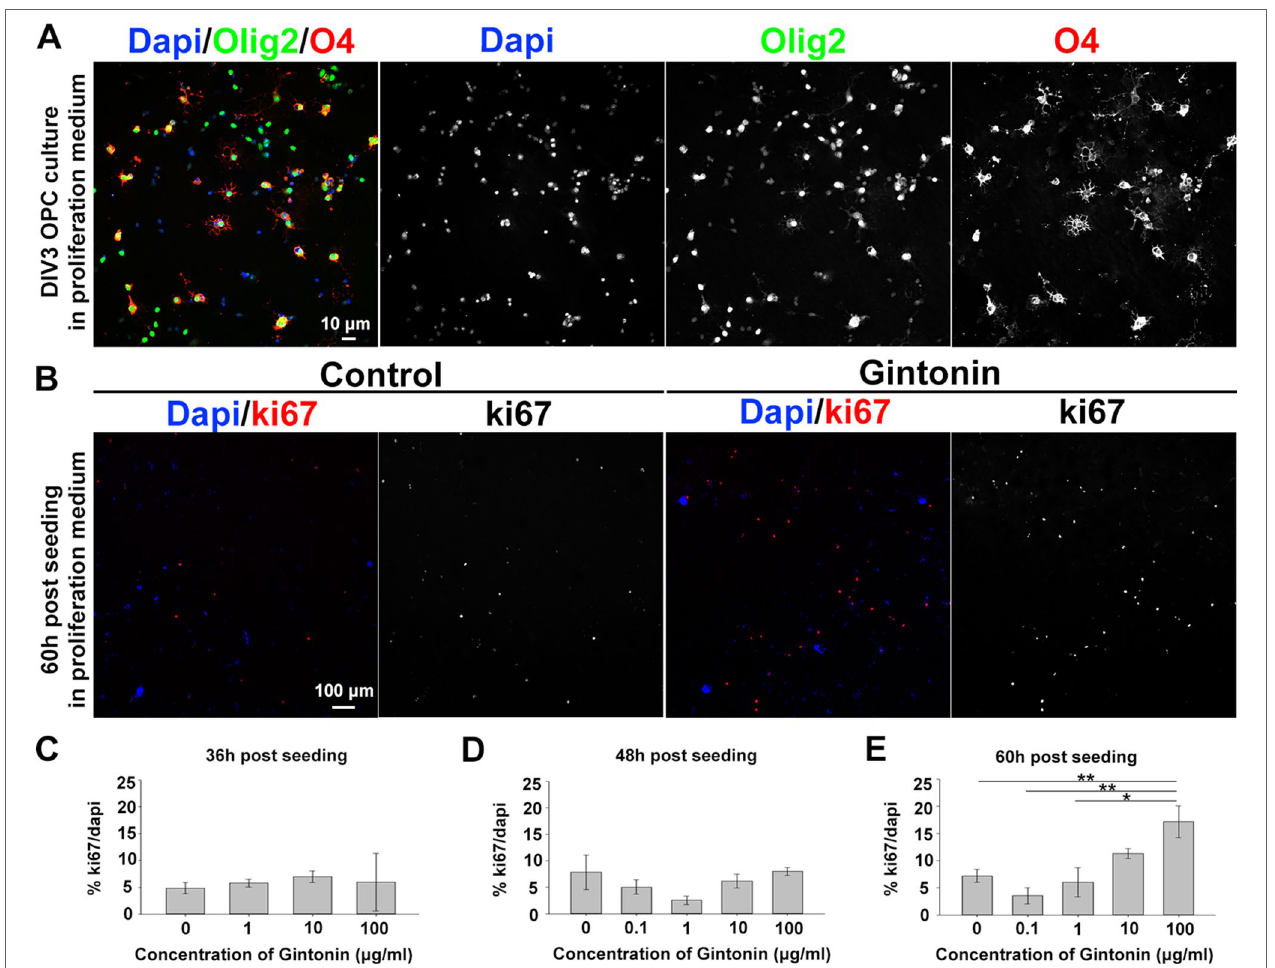
FIGURE 1 | Gintonin enhances proliferation of oligodendrocyte lineage cells in dose- and time-dependent manner. (A) Representative image of OPC culture stainings to DAPI, olig2, and O4 in proliferation medium at DIV3 is shown. (B – E) OPCs were cultured in proliferation medium and incubated with gintonin of 0 to 100 µg/ml for 36 (C) , 48 (D) , and 60 h (E) . After the indicated time period, cells were fixed for staining of Ki67 and DAPI for proliferation analysis. Representative pictures at 60 h post seeding are shown (B) . Significant increase was found in proliferation ratio of samples at 60 h post seeding (E) (* p < 0.05, ** p < 0.01, one way ANOVA, Bonferroni post-test, N = 3–8). Bars represent mean ± S.E.M. Scale bars, 10 μm (A) , 100 μm ( B)